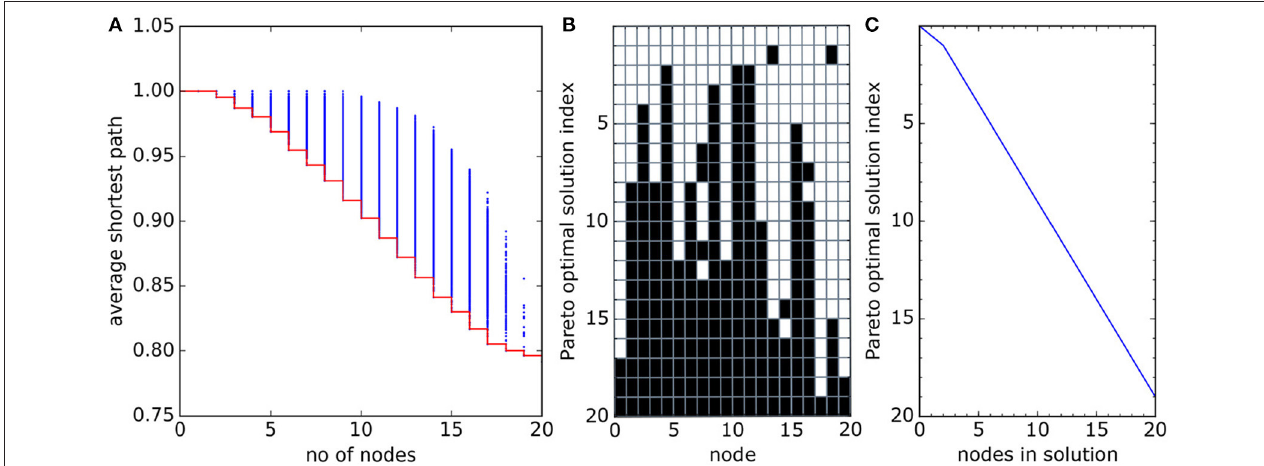
FIGURE 5 | (A) All possible cost/average shortest path function pairs (“solutions,” blue dots) for the network in Figure 2A . The Pareto optimal solutions lie on the red line. (B) Node structure of the Pareto optimal solutions. Each row represents an optimal subnetwork, each column a network node. Black filled squares are nodes included in the optimal subnetwork. The “Pareto optimal solution index” (y-axis) is a numbering of the optimal subnetworks, from smallest (single node) to largest (full network), used in the text to refer to individual solutions. The network sizes are shown in (C) . Data for this plot were found by brute force, examining all 2 20 = 1,048,576 possible networks.